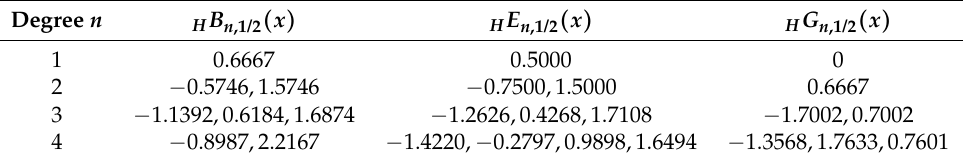
Table 7. Real zeros of H B n ,1/2 ( x ) , H E n ,1/2 ( x ) and H G n ,1/2 ( x ) .